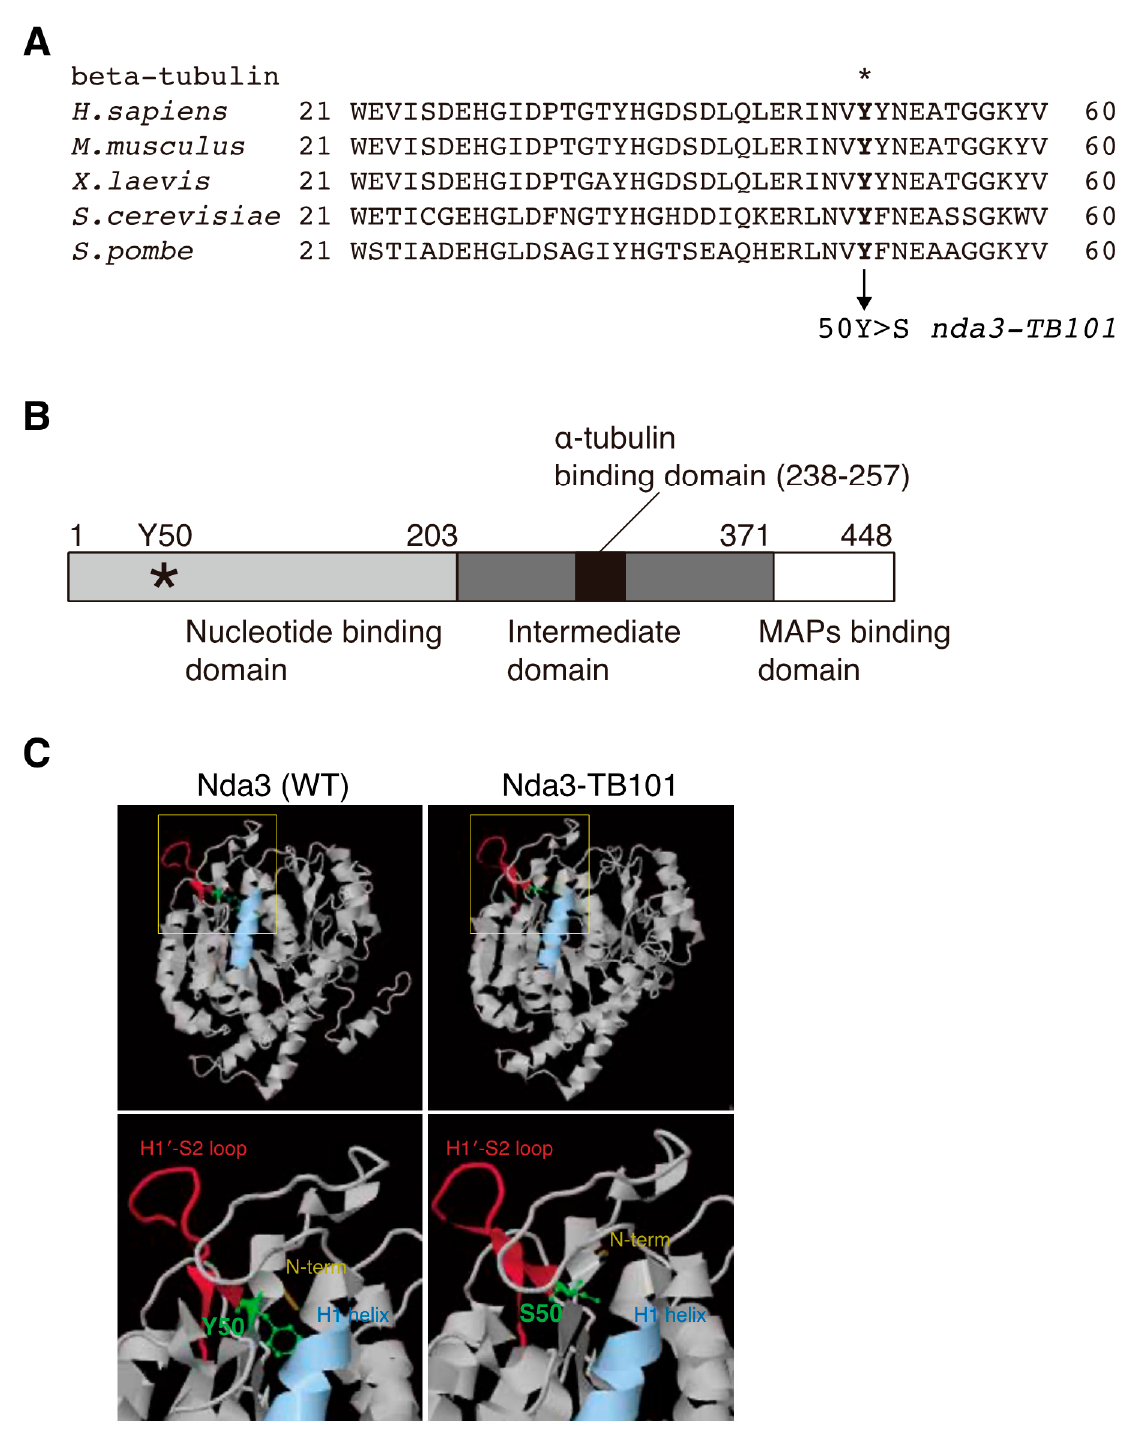
Figure 2. The Y50S mutation is found in the mutant β -tubulin Nda3-TB101. ( A ) Alignment of a part of β -tubulin proteins (aa 21–60) of indicated organisms. The S. pombe β -tubulin mutant protein Nda3-TB101 contains a single missense mutation that substitutes the conserved tyrosine residue (asterisk) to a serine (Y50S). ( B ) A domain structure of S. pombe β -tubulin Nda3. Y50 (asterisk) resides in the nucleotide (GTP/GDP) binding domain in the N-terminus. ( C ) Predicted structures of Nda3 (WT) and Nda3-TB101 containing Y50S substitution. The Phyre2 algorithm was employed to predict protein structures. The entire structure (top). Insets include the Y50 (or S50) containing regions and are shown magnified (bottom). Red, H1 (cid:48) -S2 loop; green, Y50 and S50; yellow, N-terminal end; light blue, H1